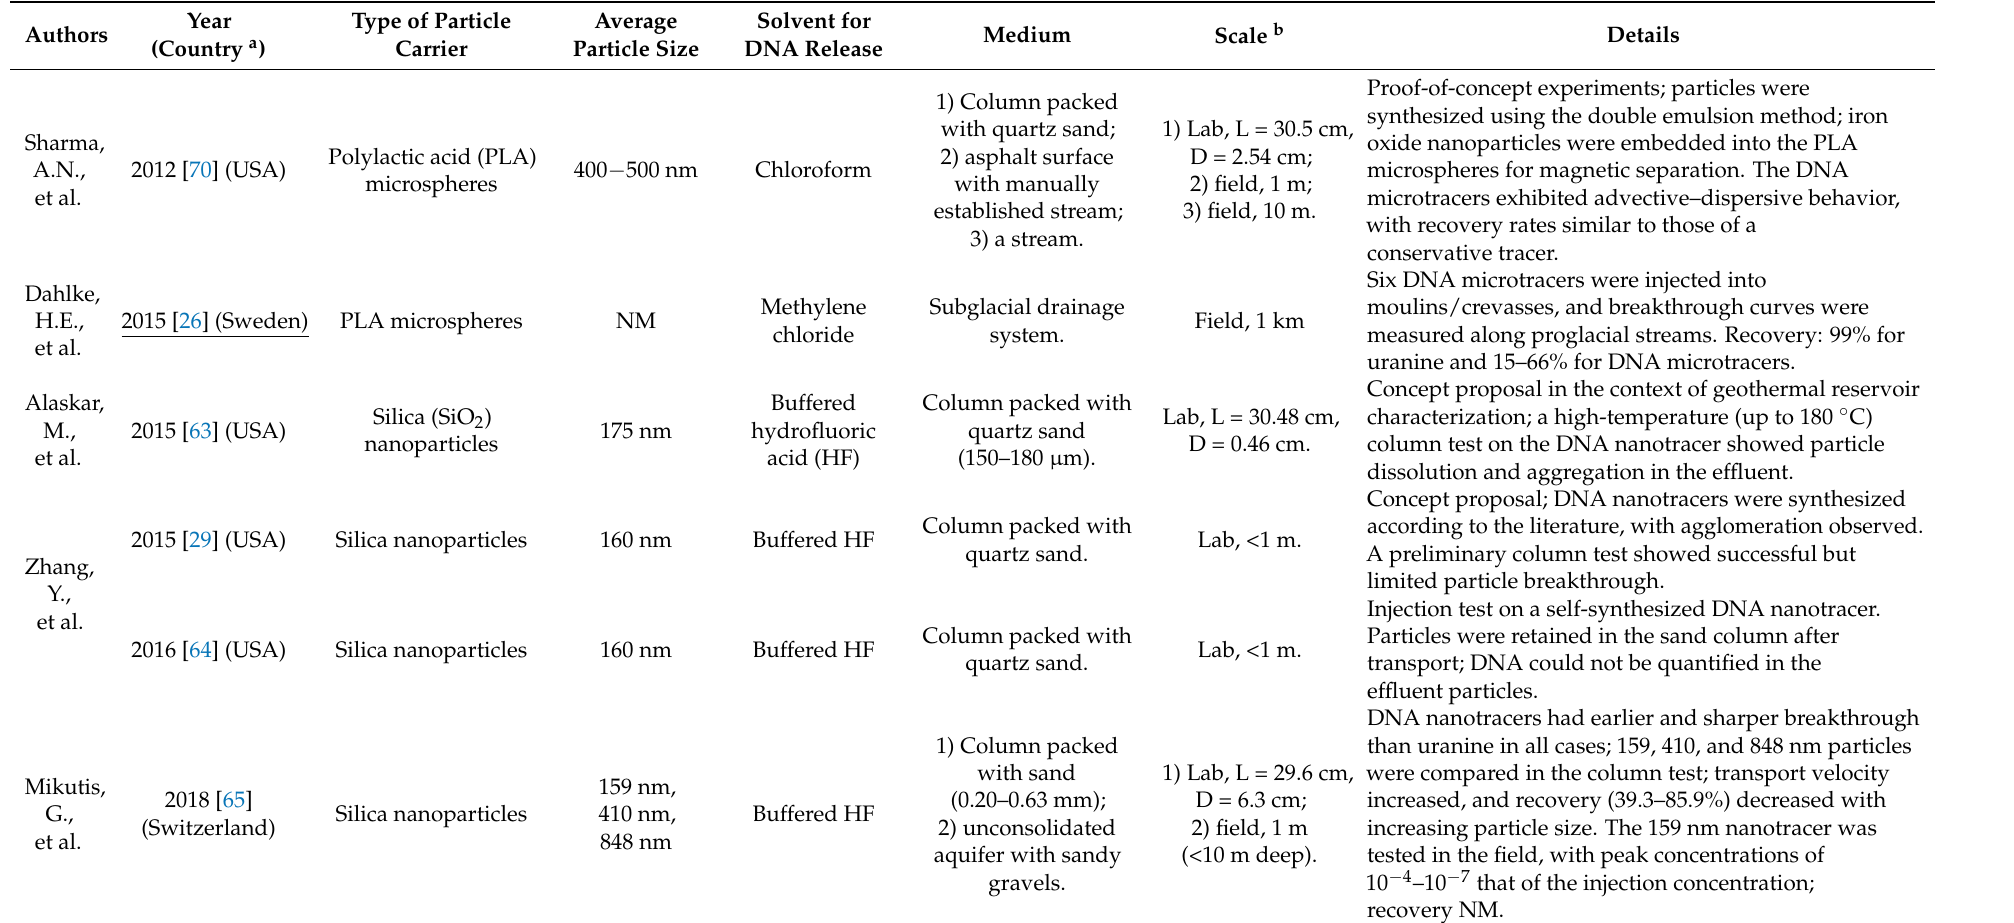
Table 2. Summary of the literature on the use of DNA encapsulated into micro-/nanoparticles as hydrological/reservoir tracers. Studies are grouped according to the first author and are presented in chronological